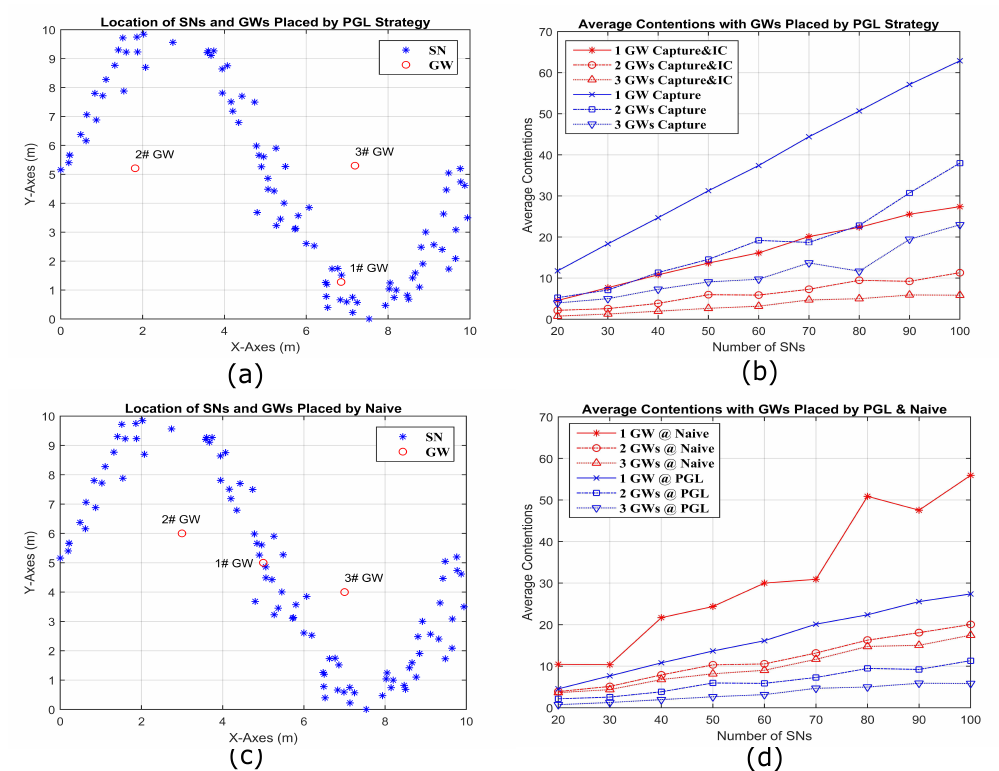
Figure 12. Simulation visualizations for three GWs placed by PGL ( a ) and by naive placement ( c ) along a sine wave composed by 100 SNs. ( b ) The average contentions comparing in different number of GWs by capture and IC to capture only separately; and ( d ) the average contentions for capture and IC comparing in different number of GWs placed by PGL and